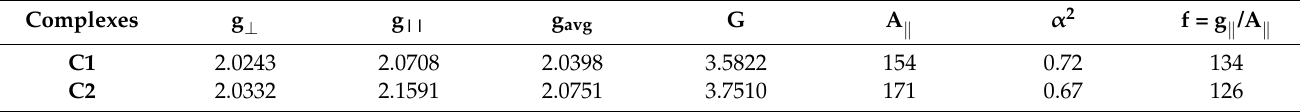
Table 1. ESR spectral values (g || and g ⊥ ) and bonding parameters of C1 and C2 complexes. Complexes